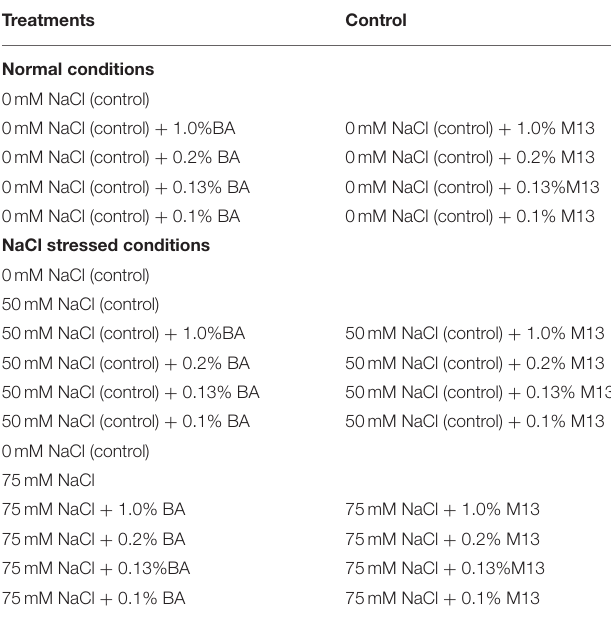
TABLE 2 | The treatments and controls used in the study. BA refers to Bacillus amyloliquefaciens cell-free supernatant, M13 refers to M13 bacterial growth